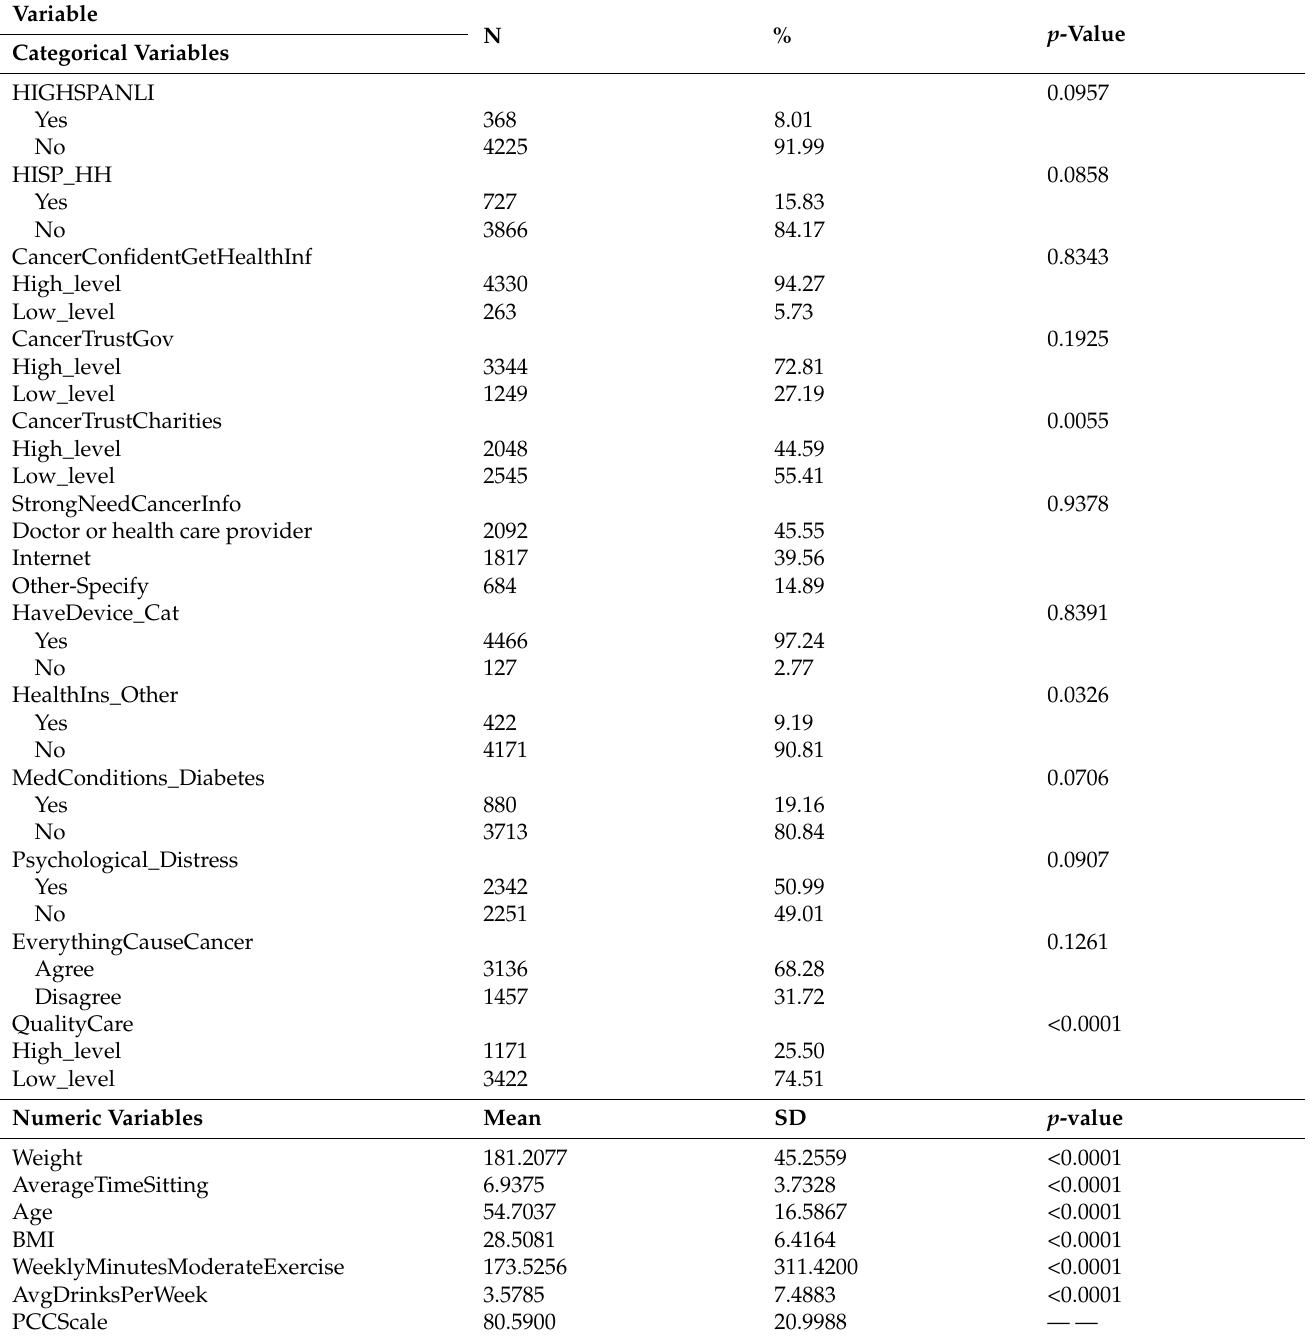
Table 1. Distribution of the variable characteristics in the HINTS